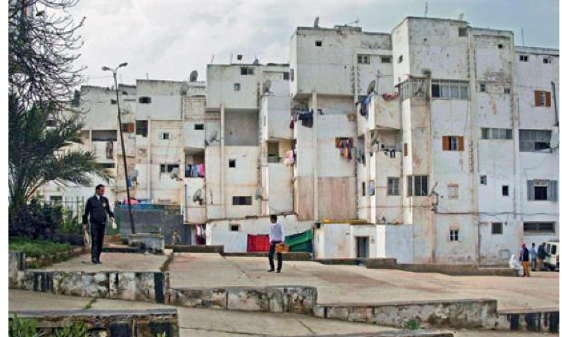
Figure 3 André Studer & Jean Hentsch, Sidi Othman Apartment Buildings , Casablanca (1955), (Url 2).